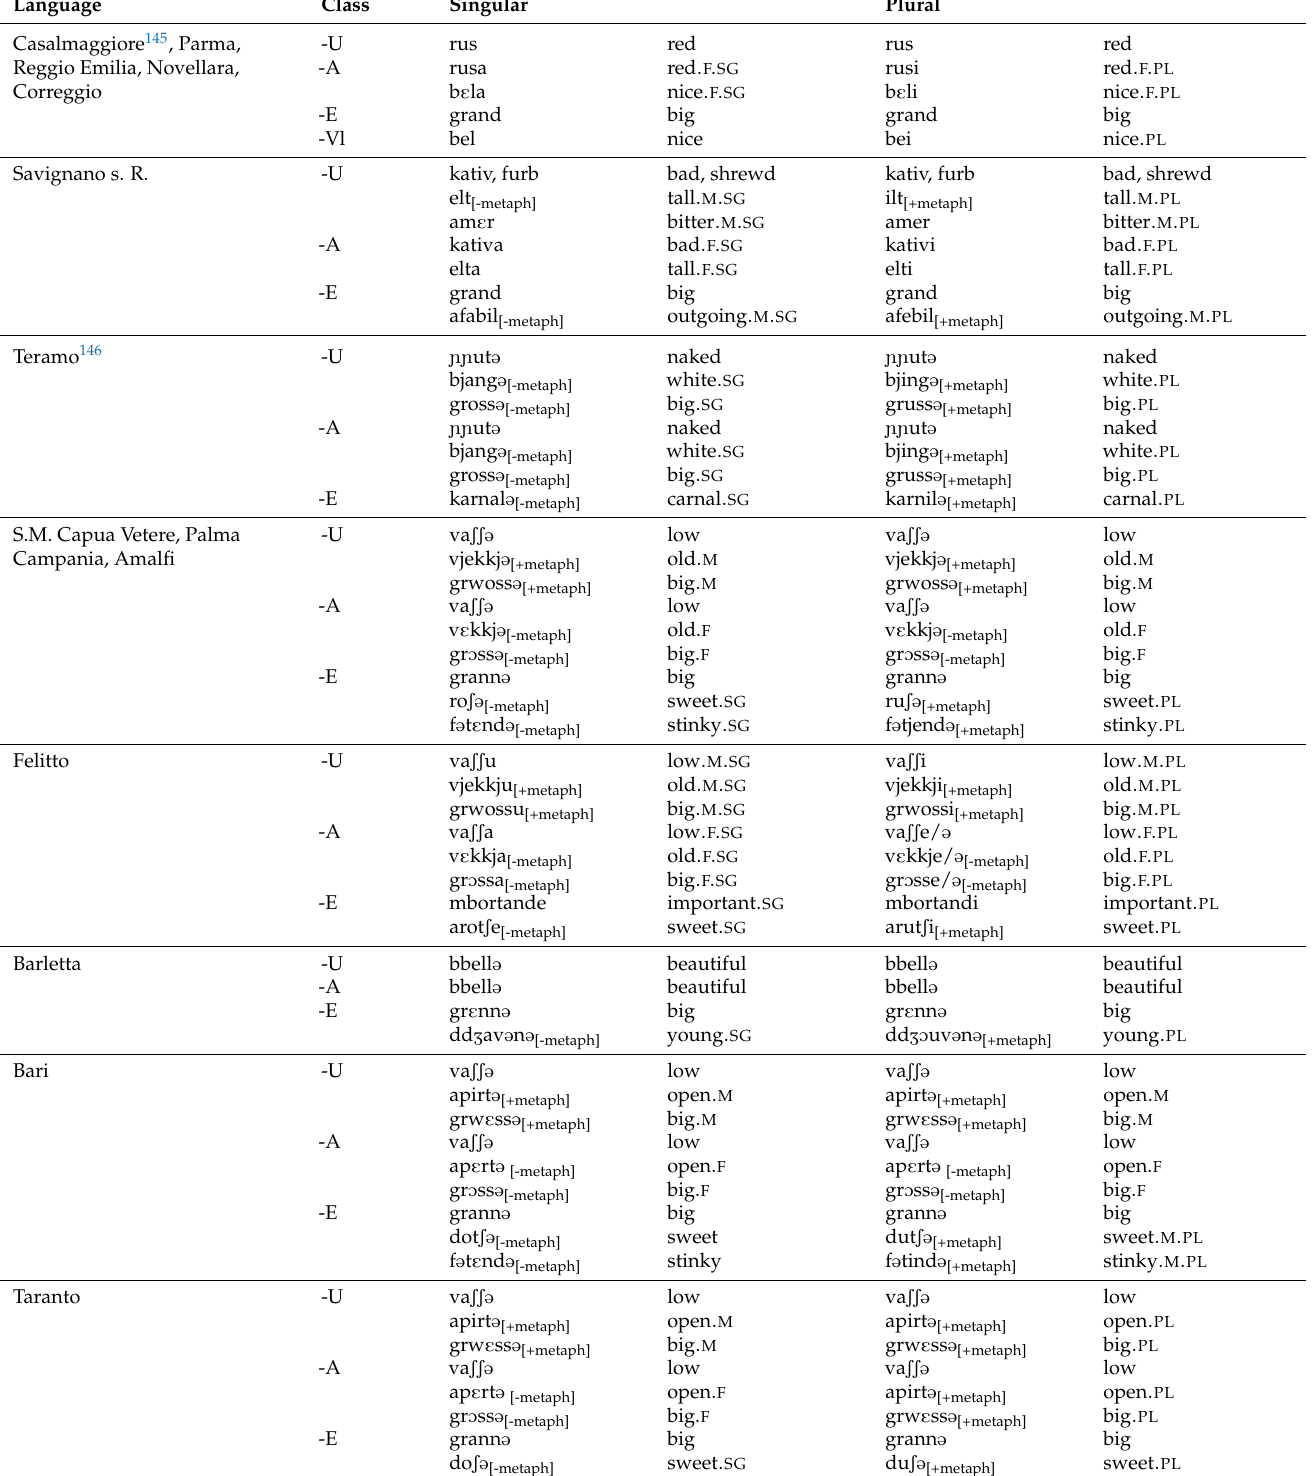
Table A5. Adjectives.